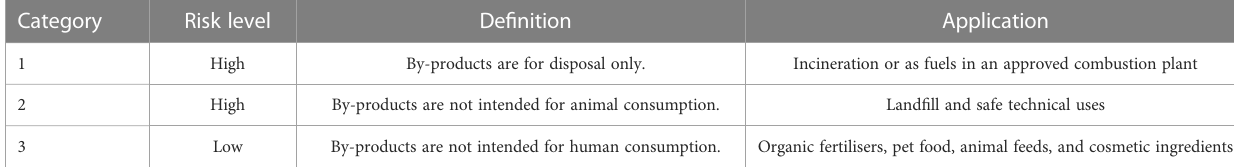
TABLE 1 Different categories of by-products with their risk levels, de fi nitions, and legal applications according to EU regulation 1069/2009. Category Risk level De fi